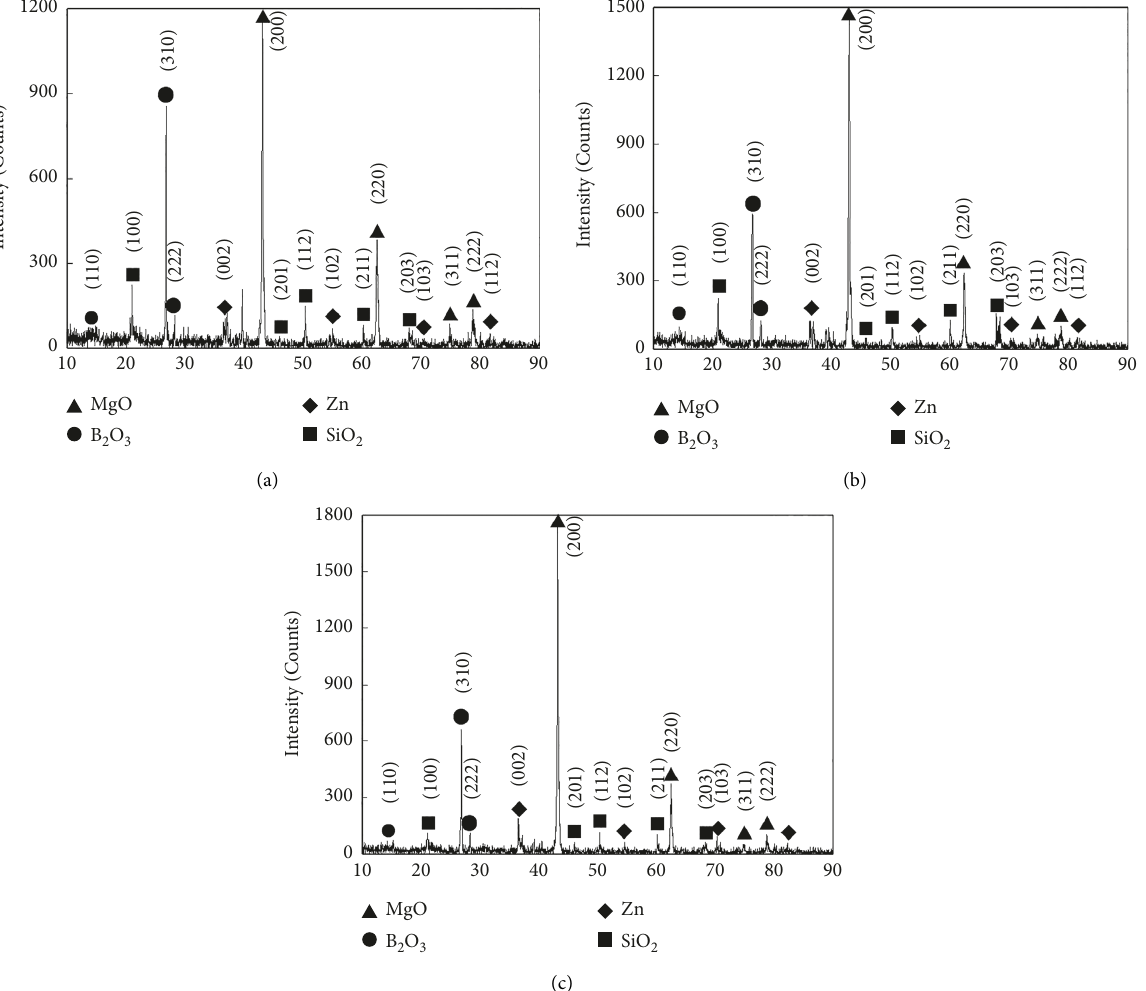
Figure 4: XRD composition analysis of coating (C). (a) C1. (b) C2. (c)